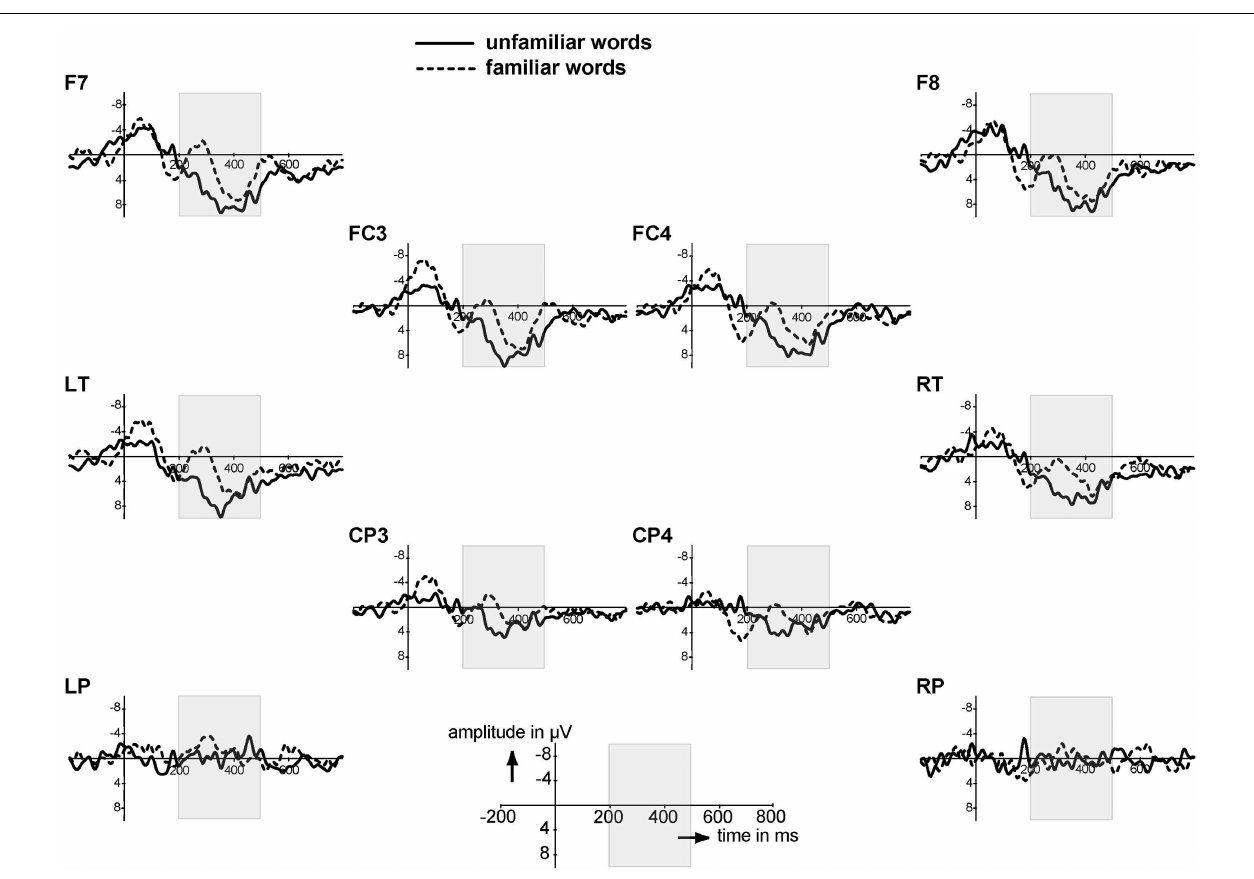
FIGURE 1 | Event-Related Brain Potentials to the unfamiliar (word position 1 & 2) and familiar (word position 9 &10) isolated words on a subset of electrodes; negativity is plotted upwards. Electrodes are laid out as they are on the scalp.The gray area indicates the time window of 200–500ms.